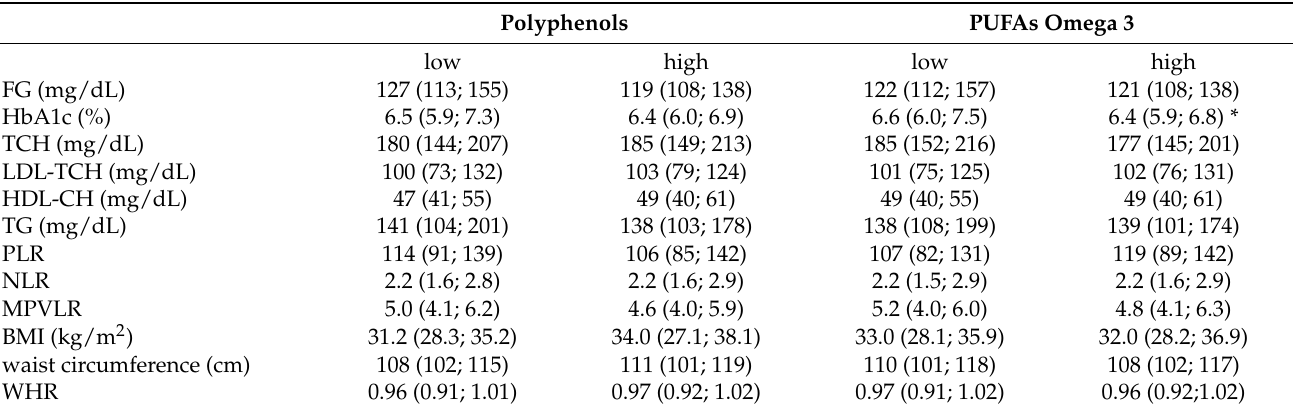
Table 3. Biochemical, inflammatory and anthropometric parameters in the T2DM patient groups with low and high polyphenol or PUFAs omega 3